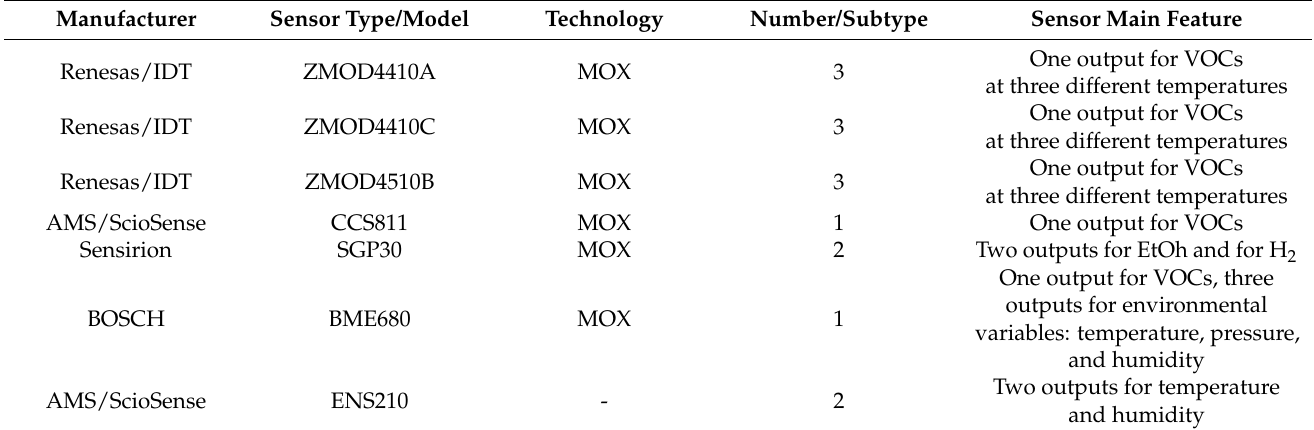
Table 1. Description of the sensors used in the sensor